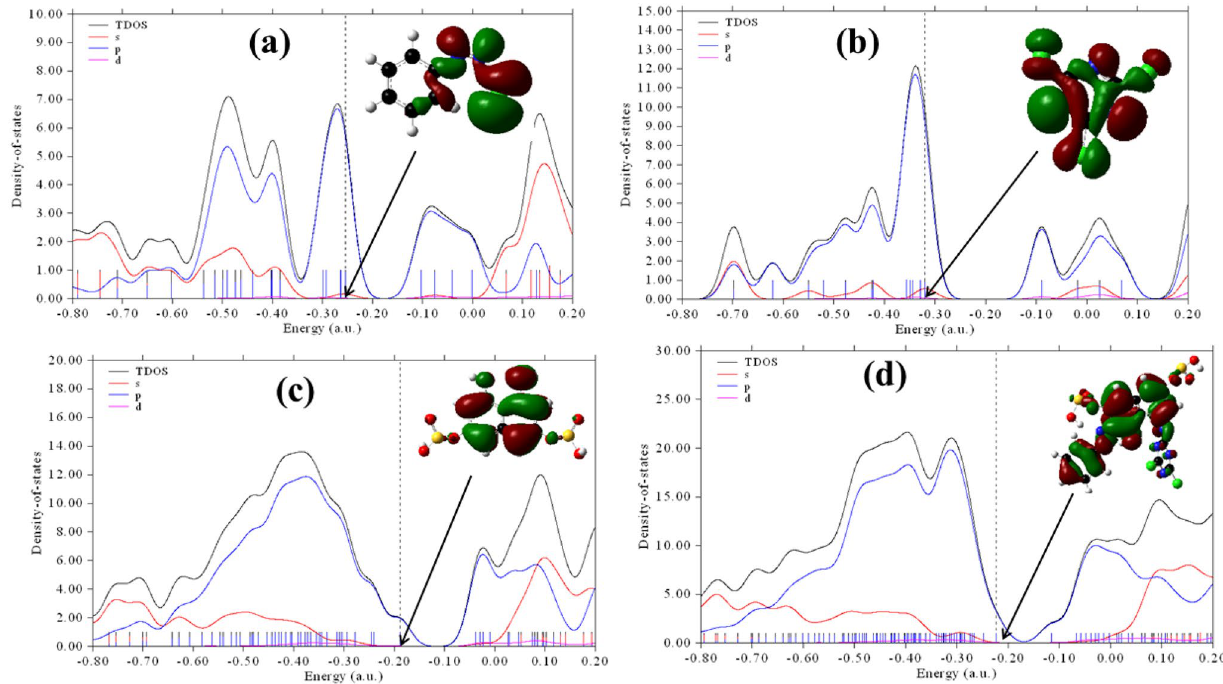
Fig. 8 Density of State (DOS) Plots for the s, p and d orbitals for a benzenediazonium fragment b 2,4,6-trichloro-1,3,5-triazine frag- ment c 4-amino-5-hydroxynaphthalene sulfonic acid fragment